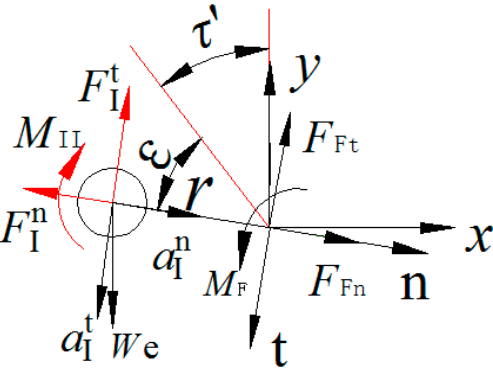
Figure 7. Force analysis diagram of the secondary balance.